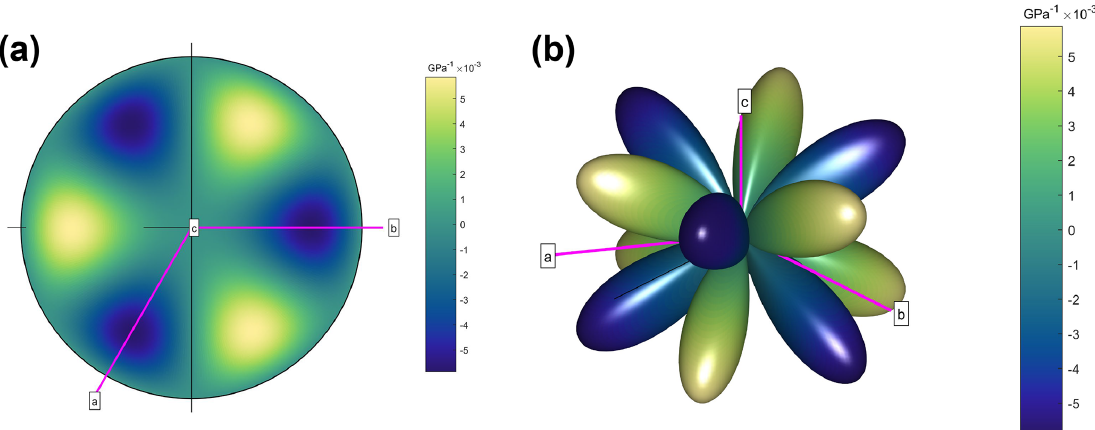
Figure 18. Anisotropy of (cid:49)s (cid:48) for Dauphiné twinning in α -quartz. (cid:49)s (cid:48) is the difference in the compliance s (cid:48) between the twinned and un- 11 11 11 twinned orientations for each direction. (a) Stereogram (lower-hemisphere equal-area projection) and (b) a 3D representation surface, both with the crystallographic reference axes marked. The directions represented by pale yellow-to-green colours will be favoured for twinning, whereas the directions shown in blue will